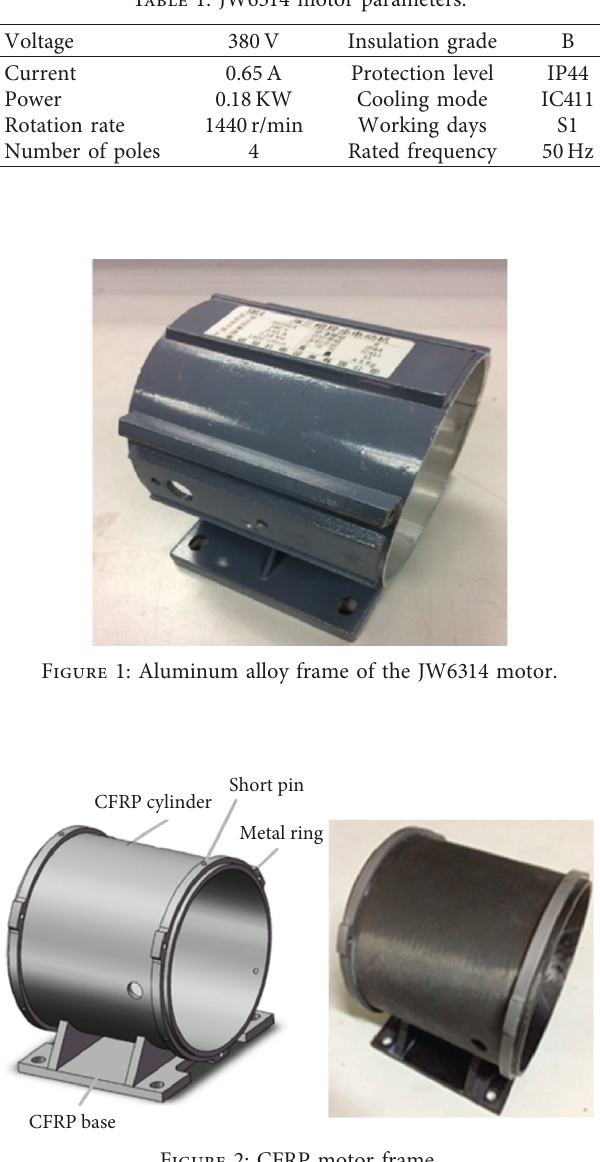
Figure 2: CFRP motor